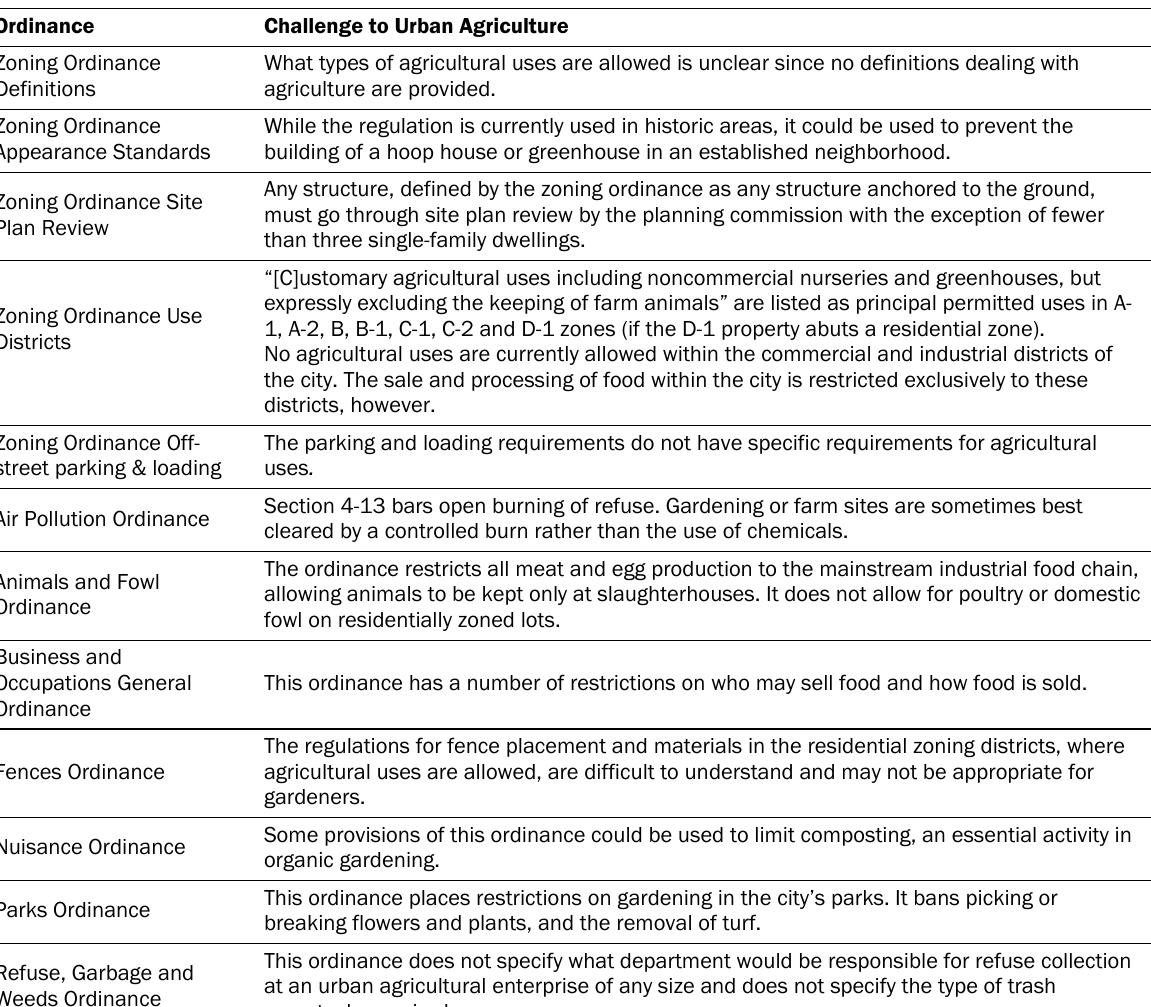
Table 1. Ordinance Challenges to Urban Agriculture in Flint,